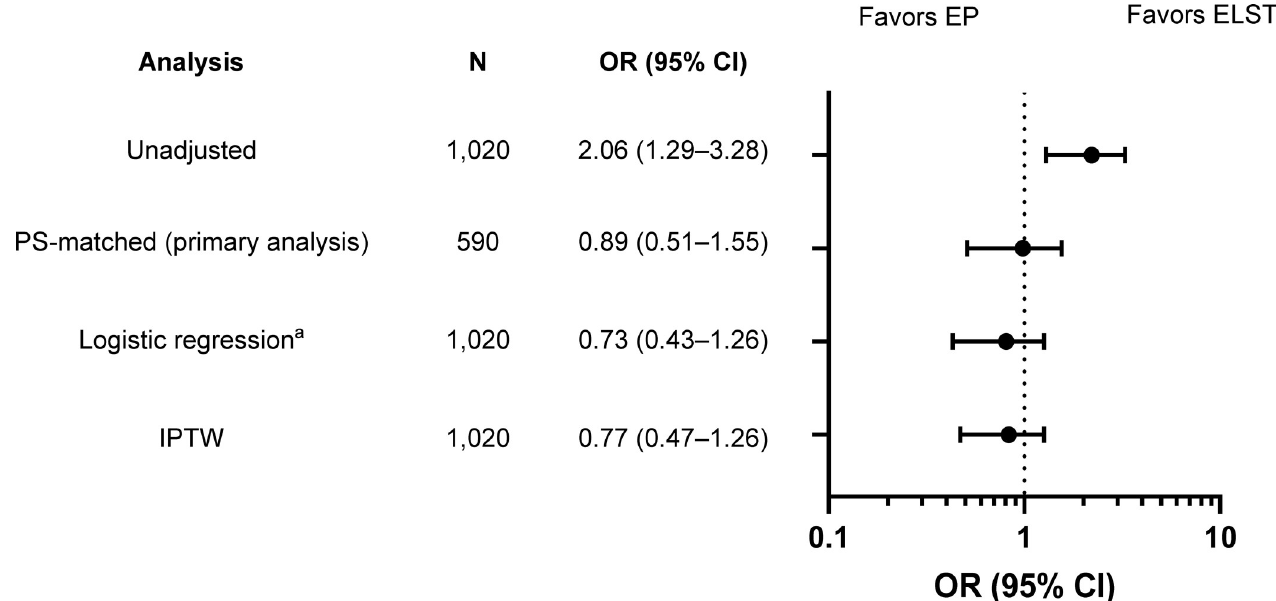
Fig 3. Odds ratios for in-hospital mortality among injured patients: EP-staffed ambulance versus ELST-staffed ambulance. The reference set was the group of injured patients transported to the ED by ELST-staffed ambulances. a Adjusted for PS as described in the Methods. CI, confidence interval, ELST, emergency life-saving technician; EP, emergency physician; IPTW, inverse probability of treatment weighting; OR, odds ratio; PS, propensity